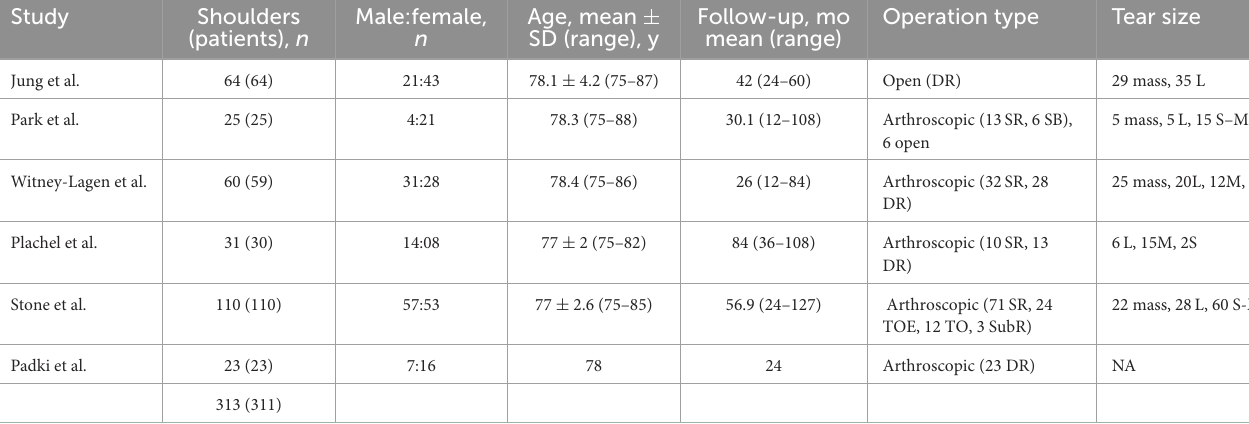
TABLE 2 Patient